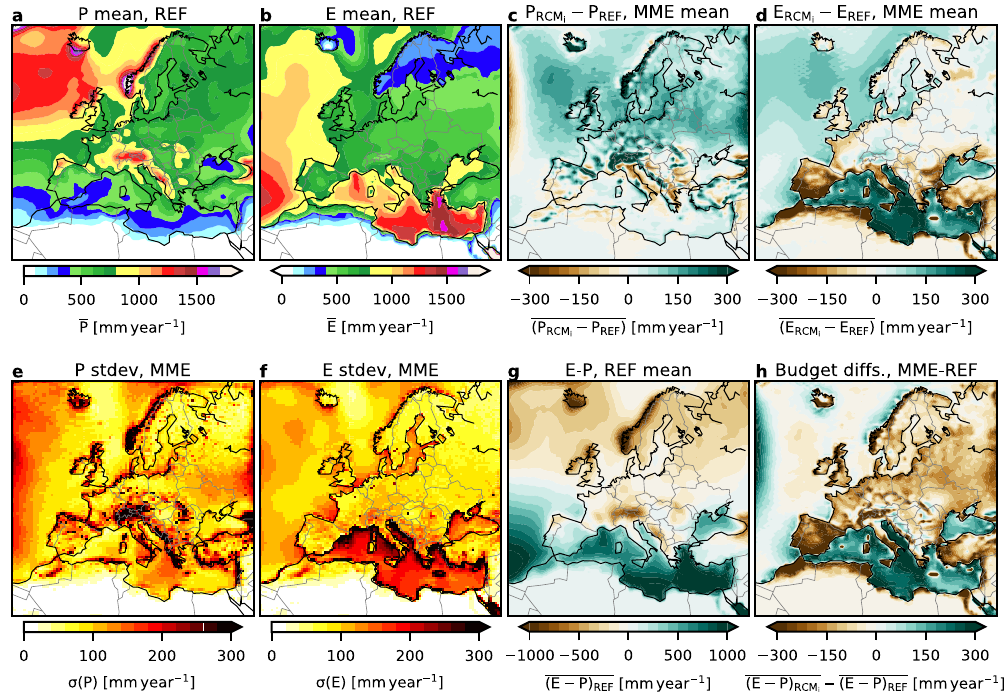
Figure 4. REF long-term mean (1989 to 2008) annual sums of ( a ) P and ( b ) E [mm year −1 ]; MME mean of individual RCM long-term mean annual sums minus REF of ( c ) P and ( d ) E [mm year −1 ]. MME standard deviation of the individual RCM long-term mean annual sums of ( e ) P and ( f ) E [mm year −1 ]. ( g ) Long-term mean atmospheric water budget ( E – P ) per grid cell for REF. ( h ) Difference of atmospheric water budgets, MME mean of the individual long-term mean budgets ( E – P ) of the RCMs minus the long-term mean budgets ( E – P ) of REF (see subplot g ). Data is shown on the native EURO-CORDEX 0.44° degree resolution EUR-44 grid. Note the Med-CORDEX data are not shown in this